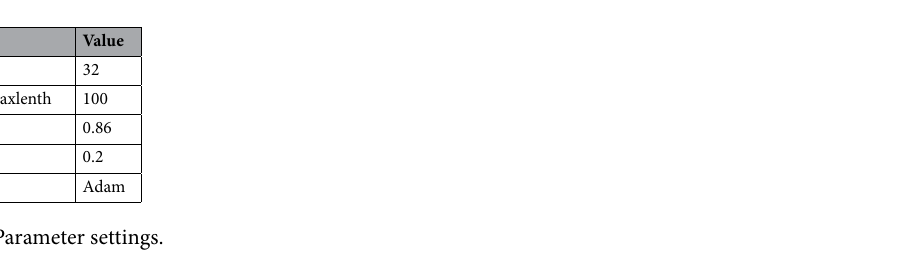
Figure 2. ( a ), ( b ) are the type distribution of entity and relation separately.